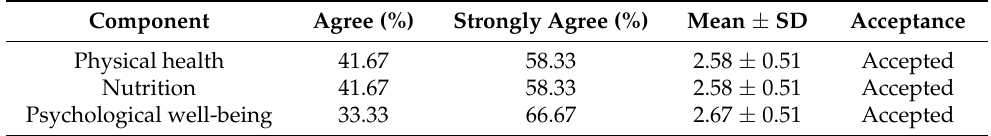
Table 7. Assessment of feasibility expectations by